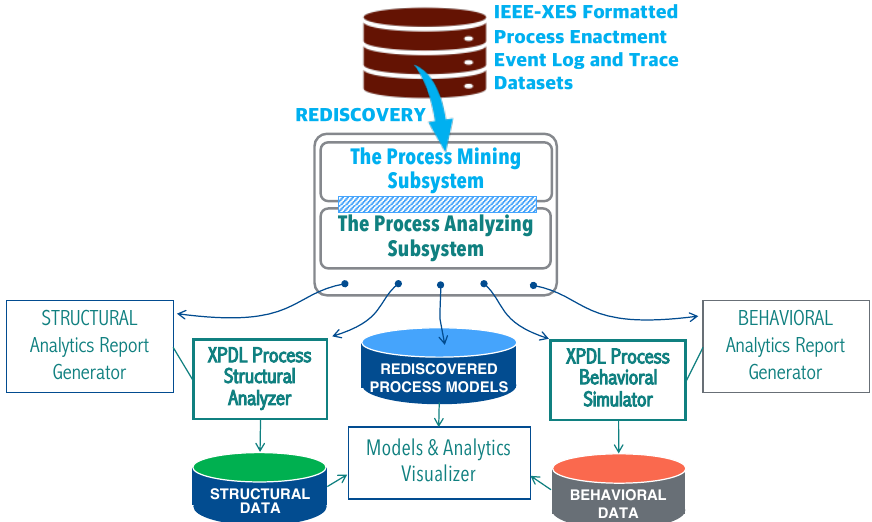
Figure 2. The ultimate architecture of the functional integration of process mining and process